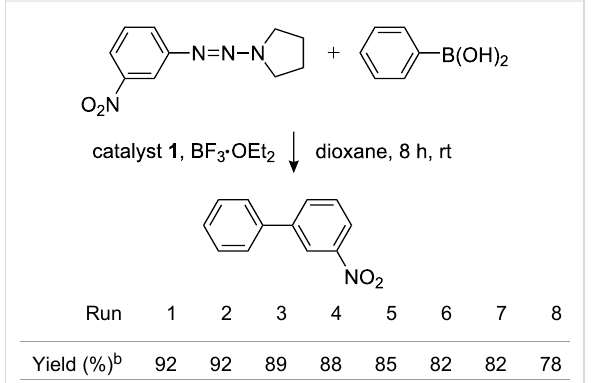
Table 4: Recycling of the polymer-supported NHC–Pd catalyst 1 a .